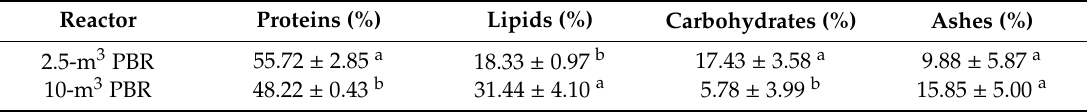
Table 2. Biochemical composition of Chlorococcum amblystomatis biomass grown in the 2.5- and 10-m 3 tubular photobioreactors (PBR). Proteins, lipids, and carbohydrates are presented as the percentage of biomass dry weight (DW). Di ff erent letters indicate significant di ff erences between reactors. Values are given as means ± standard deviation ( n =